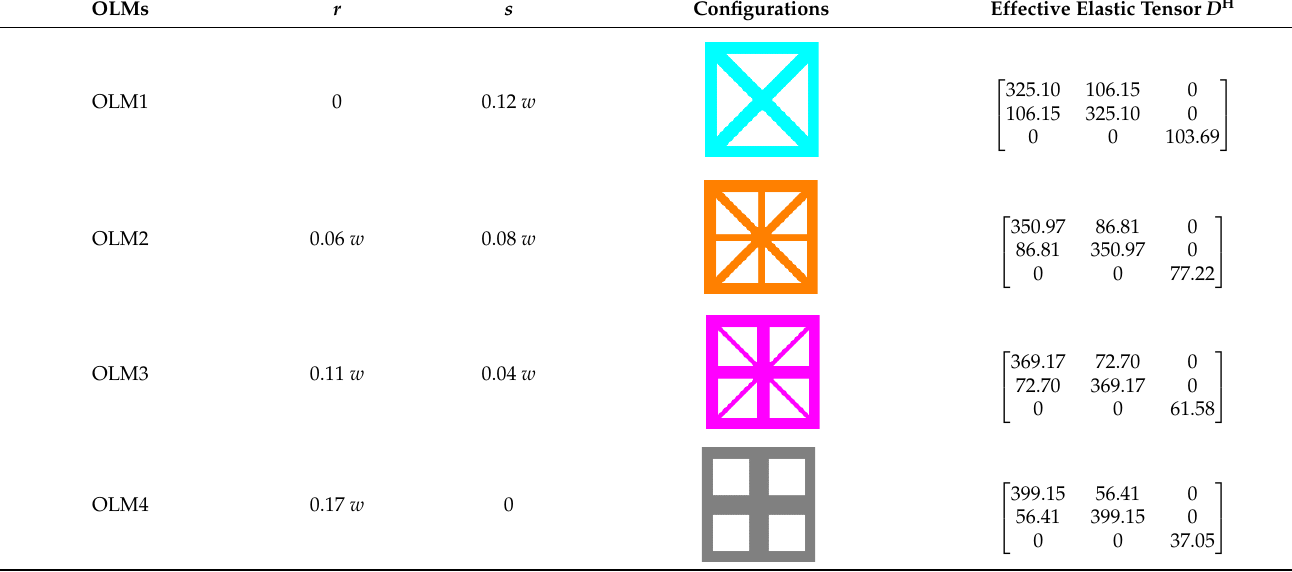
Table 2. Effective elastic tensors of ALMs.